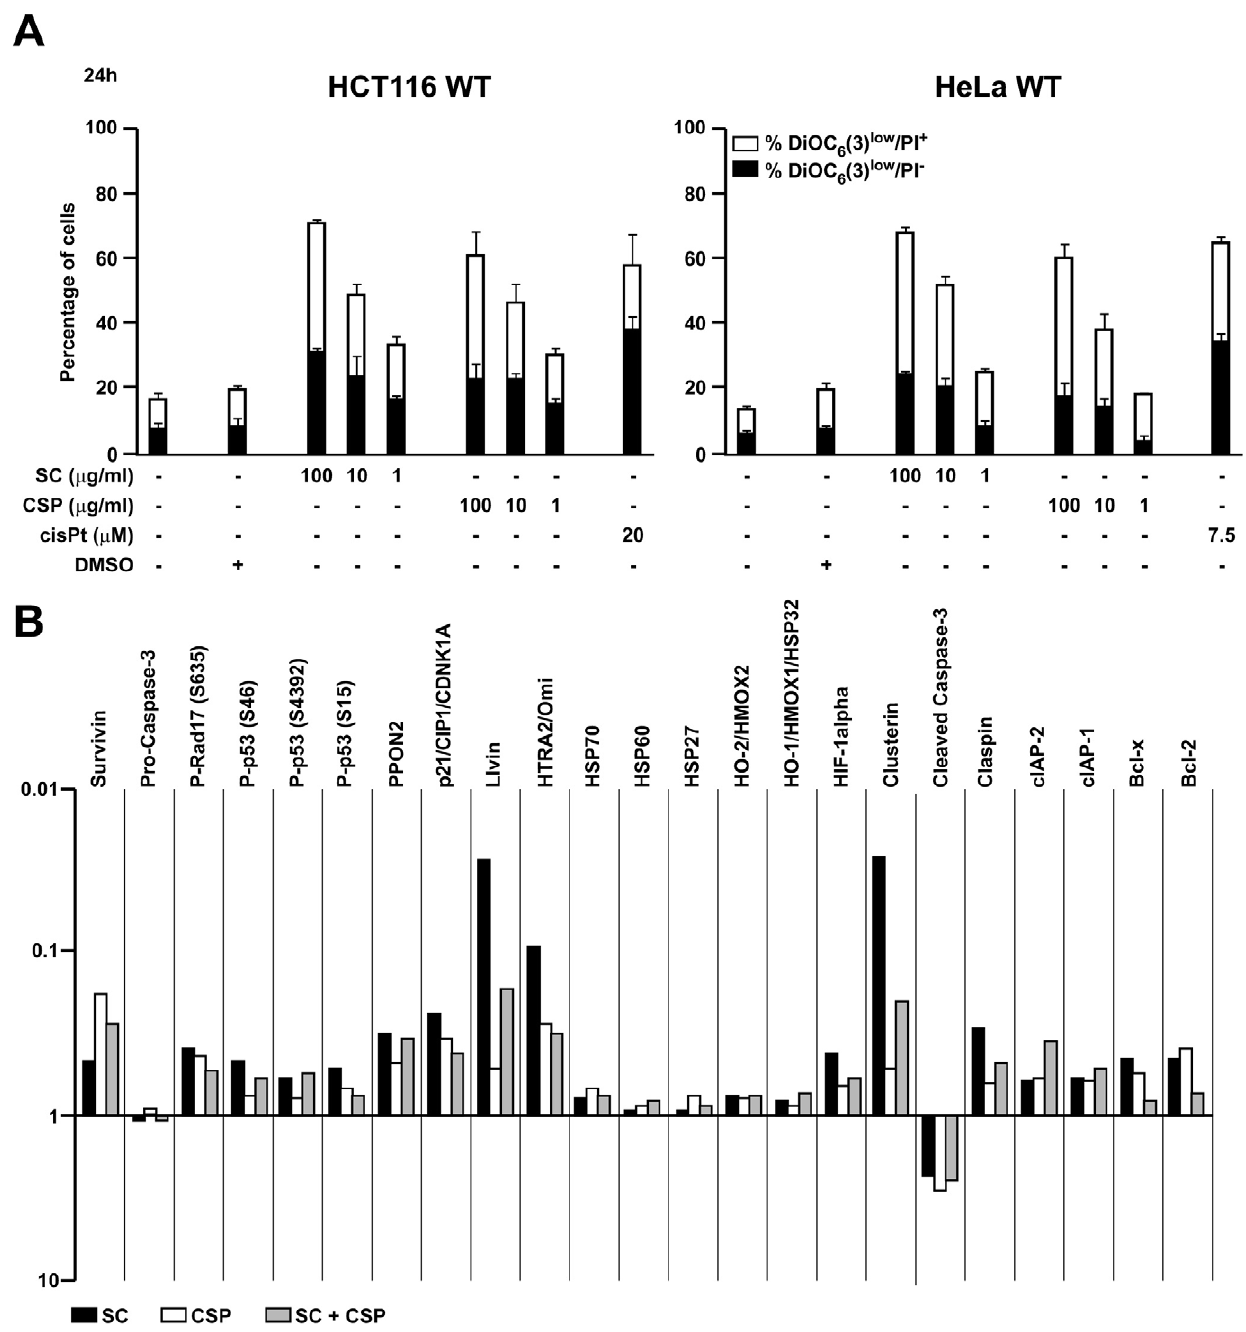
Figure 4. Effect of SC and CSP on apoptosis induction. Detection of dead and dying cells by FACS (A). Cells treated overnight with SC, CSP and cisPt were stained with DY m -sensitive dye DiOC 6 (3) and the vital dye propidium iodide (PI). The white portions of the columns refer to the DiOC 6 (3) low /PI + population (dead) and the remaining part of the column corresponds to the DiOC 6 (3) low /PI - (dying) population. Results are means 6 S.E.M. of three independent experiments. Expression profile of apoptosis-related proteins (B). Cell lysates from HeLa cells, treated with SC (10 m M) and CSP (10 m M) overnight, were analyzed by human apoptosis profiler. Data are expressed as means 6 S.D. of two independent experiments.